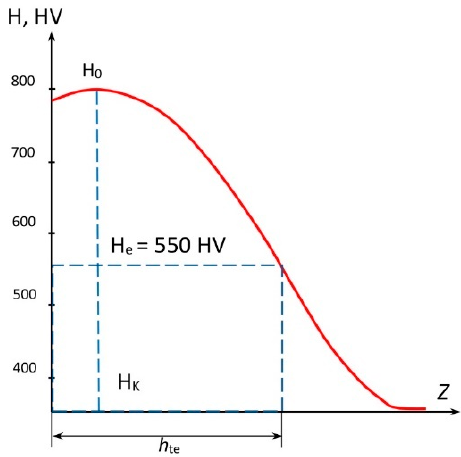
Figure 2. Hardness distribution over the thickness of the hardened (cemented) layer.